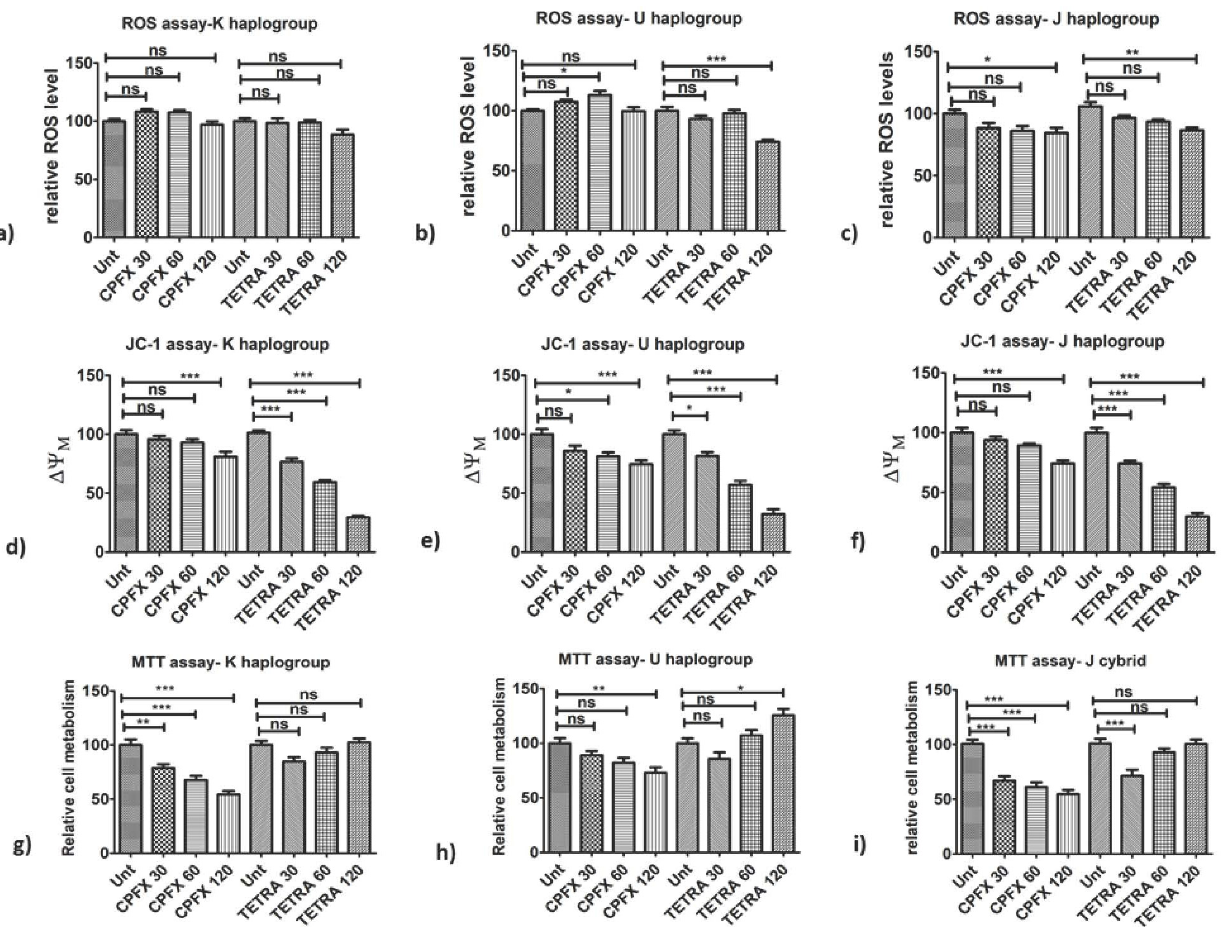
Figure 1. Impacts of CPFX and TETRA on ROS levels, ∆ ψ M and cellular metabolism of K, U and J cybrids via ROS, JC-1 and MTT assays. ( a ) no changes in ROS levels via neither antibiotics in K cybrids; ( b ) CPFX 60 µ g/mL increased ROS levels in U cybrids and diminished via TETRA 120 µ g/mL; ( c ) ROS levels reduced by CPFX and TETRA 120 µ g/mL in J cybrids; ( d ) CPFX 120 µ g/mL and all TETRA treatments reduced ∆ ψ M in K cybrids; ( e ) ∆ ψ M diminished via CPFX 60 and 120 µ g/mL and all TETRA concentrations in U cybrids; ( f ) CPFX 120 µ g/mL along with all TETRA concentrations decreased ∆ ψ M in J cybrids; ( g ) Diminished cellular metabolism with all CPFX concentrations in K cybrids; ( h ) CPFX 120 µ g/mL reduced cellular metabolism of U cybrids but higher level with TETRA 120 µ g/mL; ( i ) All CPFX treatments and TETRA 30 µ g/mL declined cellular metabolism of J cybrids. (* p < 0.05, ** p < 0.01, *** p < 0.0001).